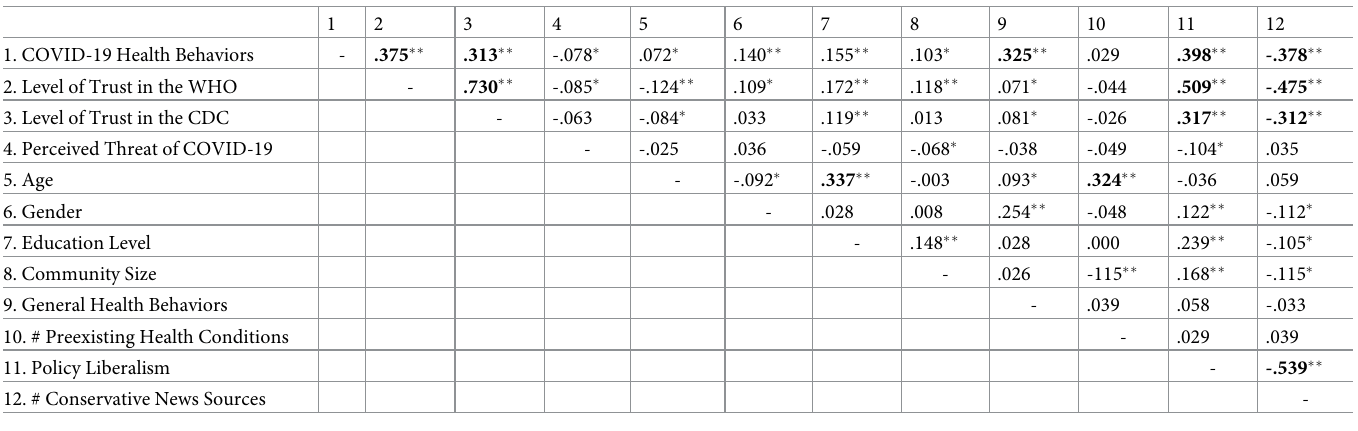
Table 2. Bivariate correlations for the sample (range